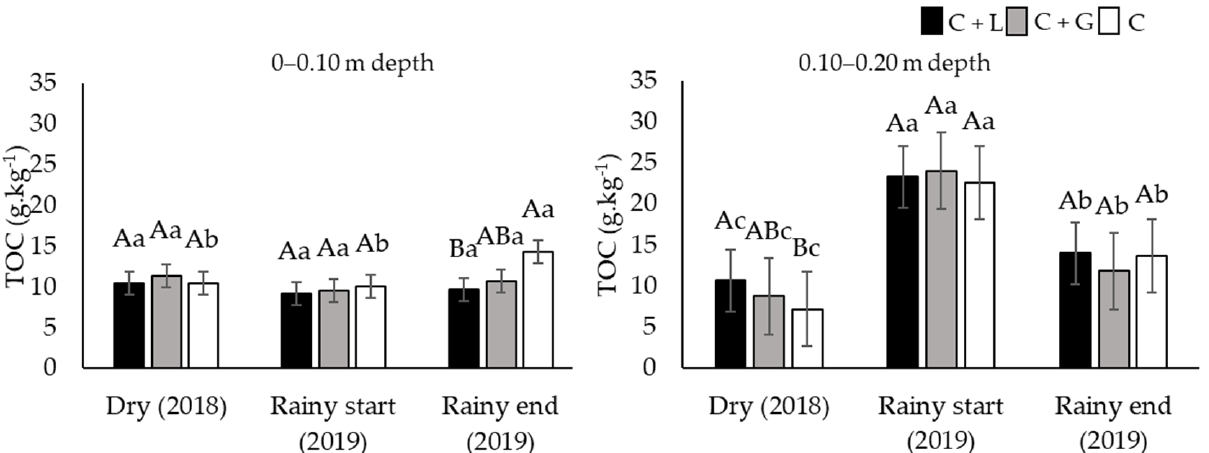
Figure 4. Total organic carbon (TOC) in the soil of different cactus cropping systems at different sampling dates. C + L: cactus + leucaena; C + G: cactus + gliricidia; C: cactus in monoculture. Different capital letters indicate significant difference ( p < 0.10) within each period of the year; different small case letters indicate significant difference within each cropping system ( p < 0.10) by PDIFF adjusted to Tukey. Bars indicate the standard error of the mean.